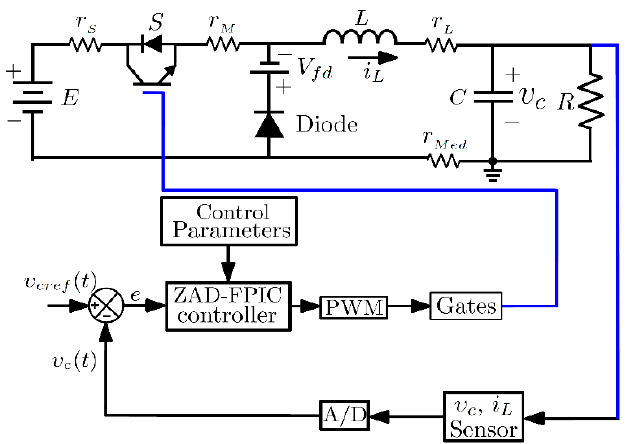
Figure 1. Buck converter controlled by Zero Average Dynamics and Fixed Point Induction Control (ZAD-FPIC).